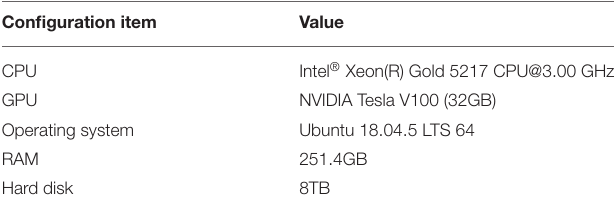
TABLE 3 | Hardware and software